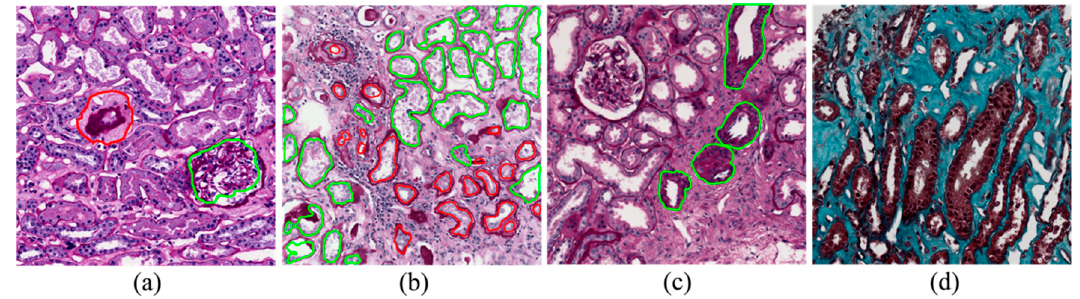
Figure 1. Histological features assessed to determine the Karpinski score. ( a ) Glomerulosclerosis: examples of a healthy and sclerotic glomerulus are shown in green and red, respectively; ( b ) Tubular atrophy: healthy and atrophic tubules are highlighted in green and red, respectively; ( c ) Vascular damage: blood vessels are outlined in green; ( d ) Cortical parenchyma: renal fibrosis is represented by the turquoise zone.